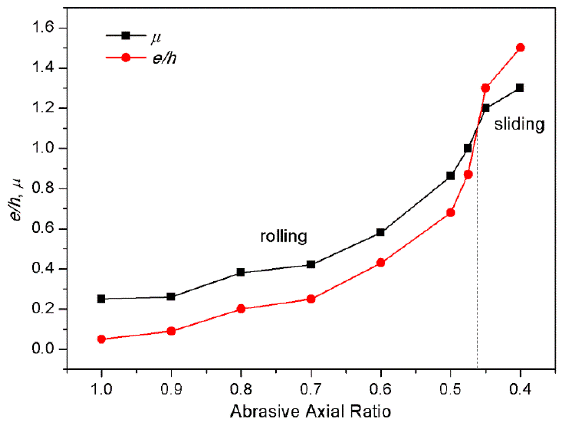
Figure 4. Average friction coefficient ( μ ) and e/h value at different axial ratio of particles.